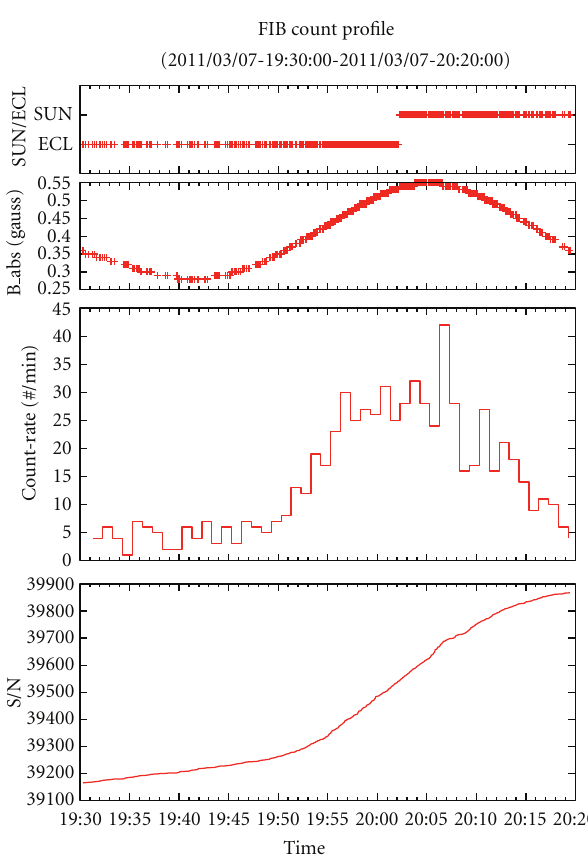
Figure 6: From the top to the bottom, each figure corresponds to (1) the location of the satellite, whether it was over the day side of the Earth or the night side, (2) the strength of the magnetic field measured by SEDA-AP, (3) the di ff erential event rate per minute, and (4) the integral counting rate with Universal Time. The SUN or ECL of the top panel represents whether the satellite was on the day side (1) or the night side (0) of the Earth, respectively. The satellite observed the Sun after 20 :02UT. Every 45 minute, the satellite passes over the Equator and approaches both Polar Regions. The FIB is an omnidirectional sensor and detects neutrons from all directions. The peak during 20 :06–20 :07UT may be induced by solar neutrons.